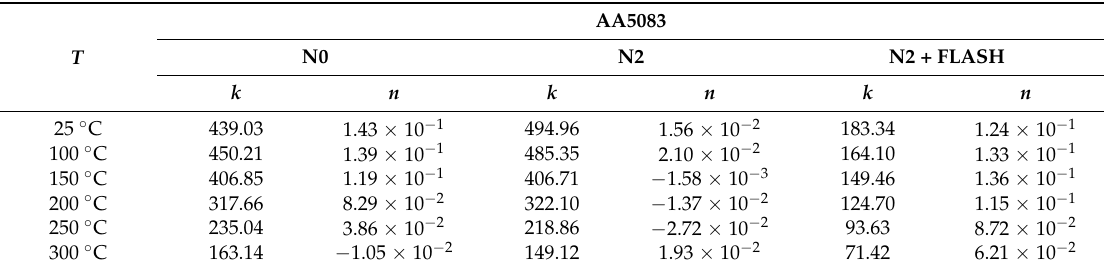
Table 7. Values for Hollomon’s parameters in the case of AA5083.